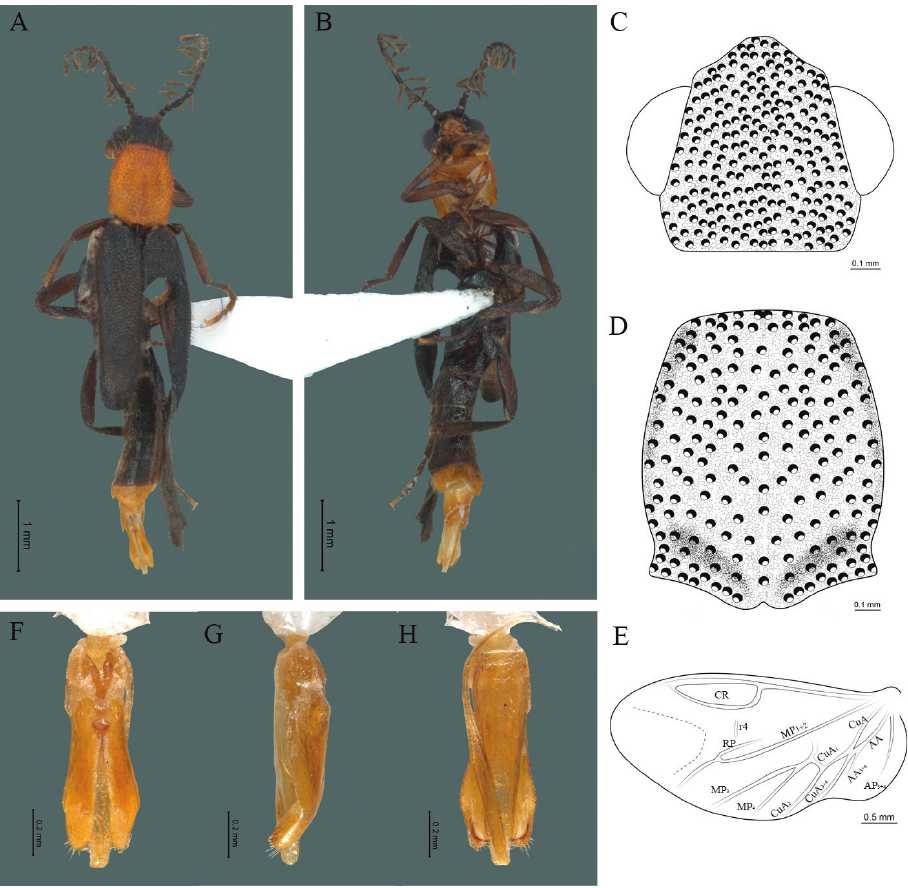
Figure 32. Cenophengus xiinbali Vega-Badillo et al. 2021, male. Habitus: A dorsal B ventral C head dorsal D pronotum E hind wing. Wing venation: CR = Radial Cell; r4 = radial 4 vein; RP = Posterior Radial vein; MP1+2 = Posterior Median vein; CuA = Cubital vein; AA and AP = Anterior and Posterior Anal veins. Aedeagus: F dorsal view G lateral view H ventral